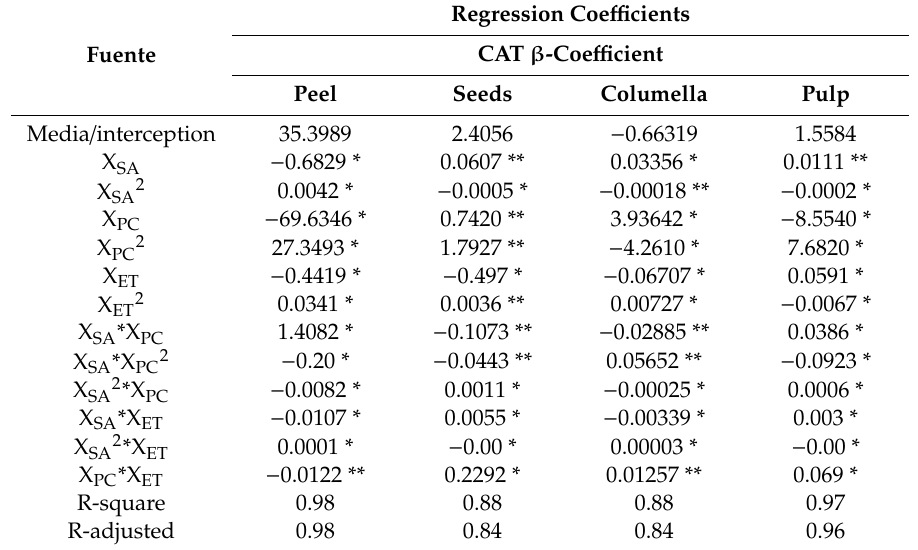
Table 3. Regression coe ffi cients of the predicted quadratic polynomial models with the conditions of ultrasound-assisted extraction on the total alkaloid content from A. muricata peel, seed, columella, and